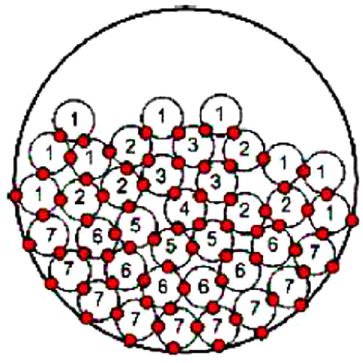
Fig. 5. Collapsed fuel bundle